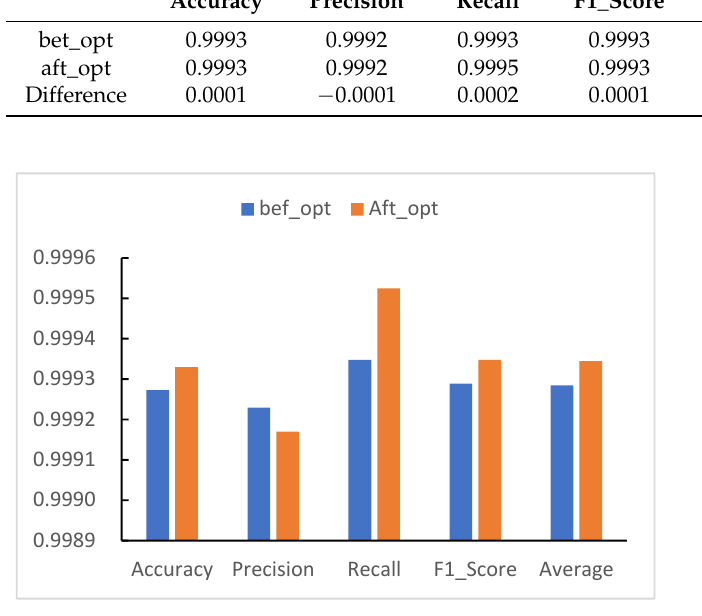
Table 11. Comparison of performance indicators before and after RF optimization.